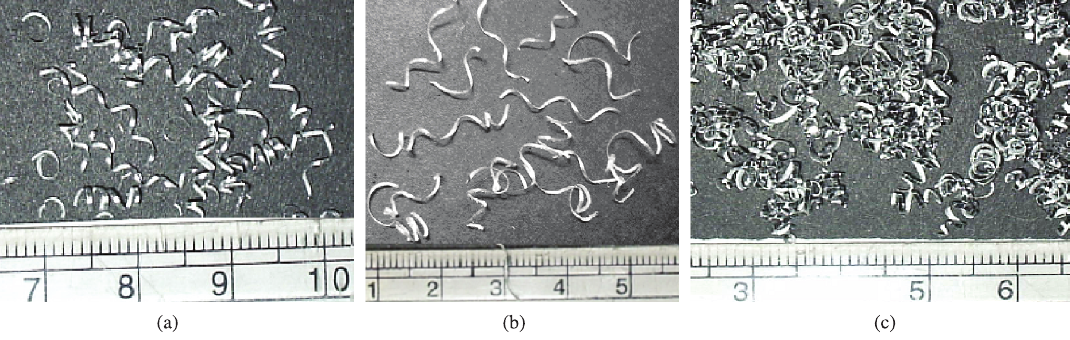
Figure 5. Chips formed during the machining of Al 2219/SiCp-Gr for both the composites at a length of cutting of 50 mm, cutting speed of 110 m/min, feed rate of 0.1 mm/rev. for (a) carbide tool (b) Coated Carbide tool and (c) PCD